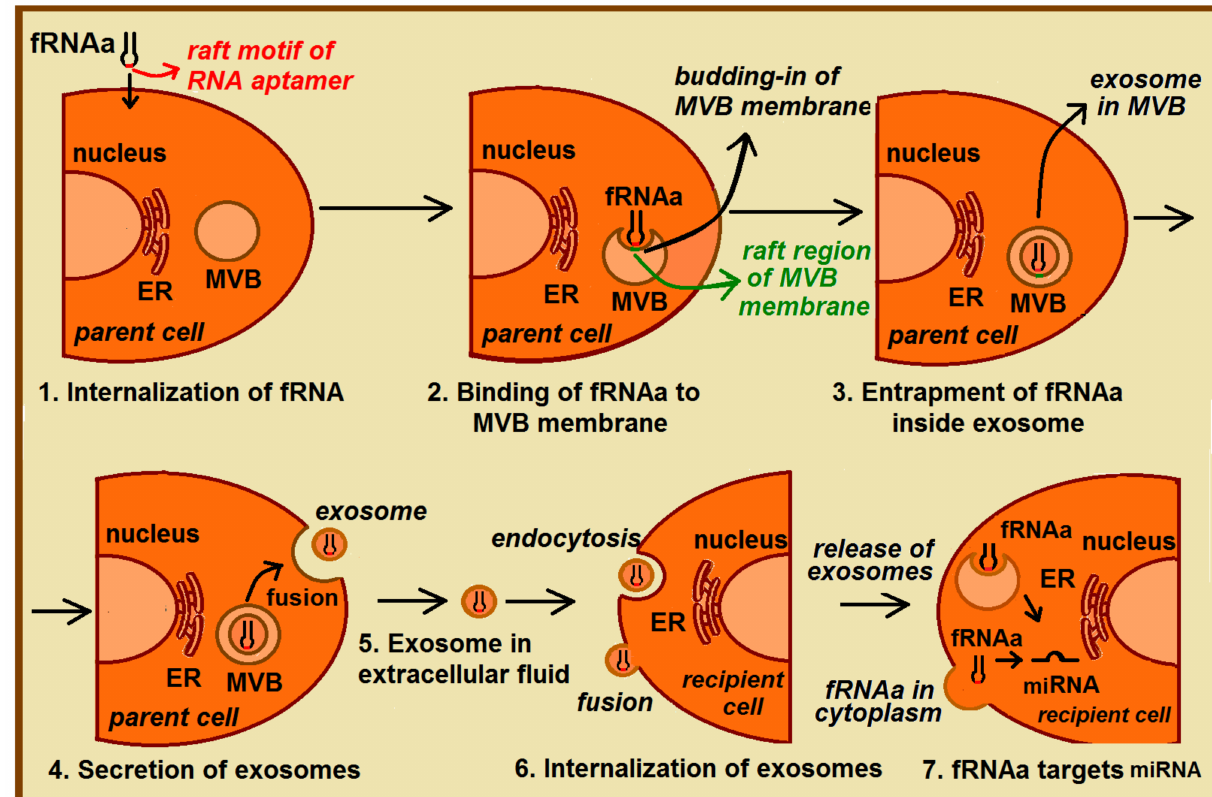
Figure 7. Proposed fRNAa delivery mediated by exosomes. The functional RNA aptamer (fRNAa) owns a therapeutic domain as well as RAFT-motif sequence and its delivery involves a few stages: (1) Internalization of the fRNAa by donor cells; (2) binding of fRNAa to the raft-like domains inside membrane of MVB; (3) entrapment of fRNAa inside ILV (exosomes), resulted from the budding-in process of MVB membrane; (4) secretion of exosomes by the fusion of MVB with the parent cell membrane; (5) exosomal transport of fRNAa in the extracellular fluids; (6) internalization of exosomes by recipient cell, resulted from the endocytosis or/and fusion of exosomes with plasma membrane; (7) release of exosome content, which allows fRNAa reach the target miRNA and induce desired effects inside the target